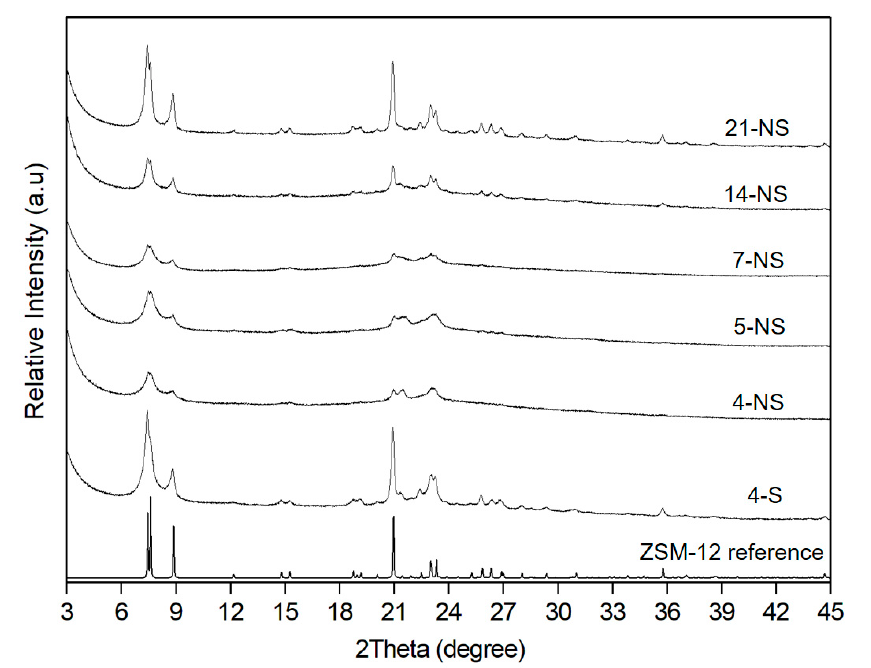
Figure 1. XRD patterns of the calcined ZSM-12 zeolites obtained by pseudomorphic transformation and XRD reference pattern of ZSM-12 zeolite [51].